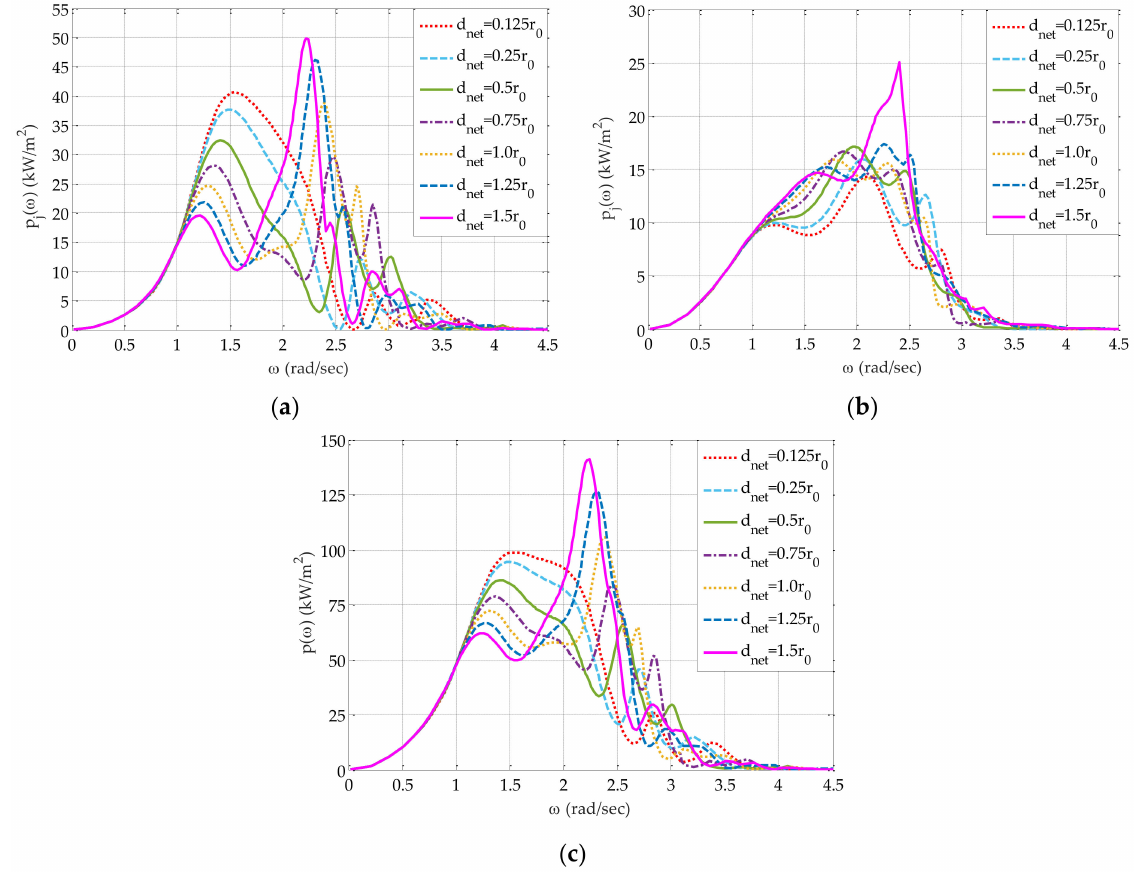
Figure 8. Effect of d net on the mean power absorbed by the oblate spheroidal WECs placed around the monopile for β = 0 o : ( a ) WEC1 and WEC4; ( b ) WEC2 and WEC3; ( c ) whole